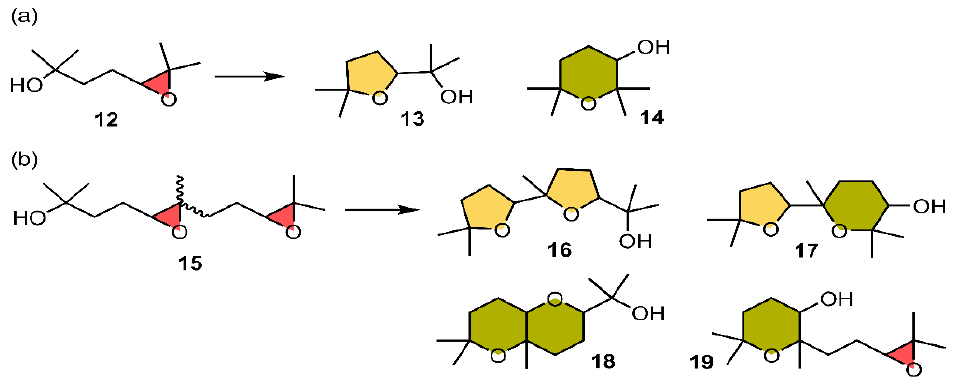
Figure 7. Schematic representation of two epoxide-opening ether cyclizations studied by Hao and collaborators [94] yielding compounds (a) 14 and (b) 16 to 19 .